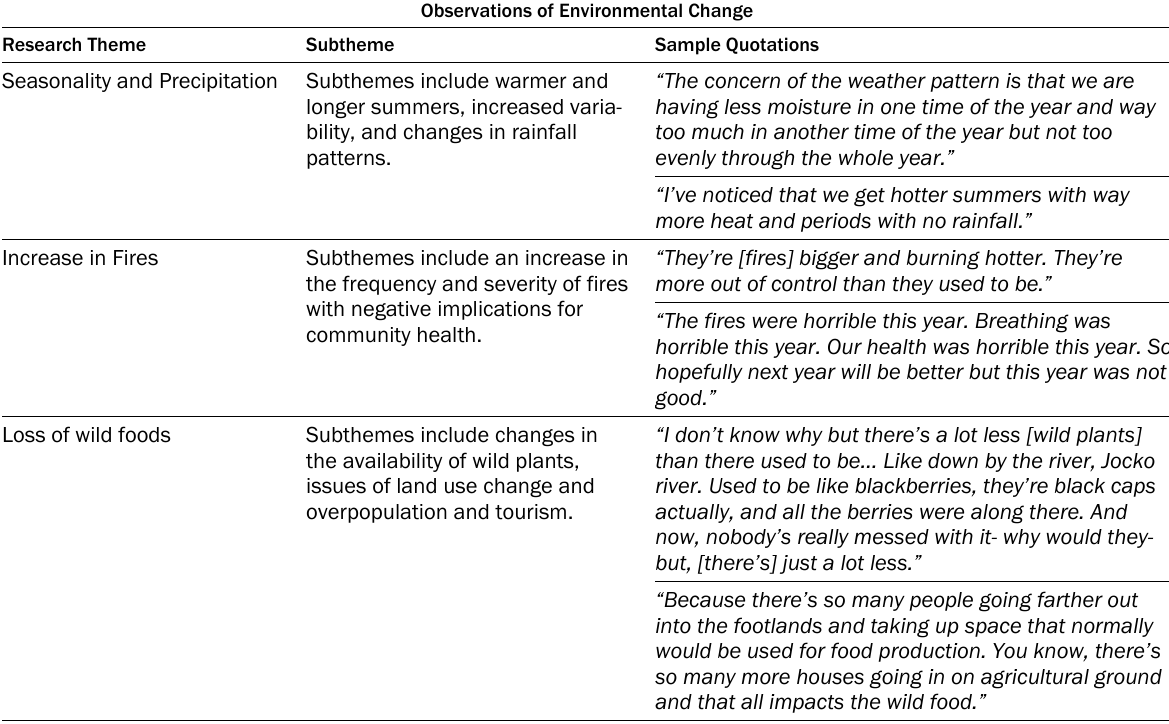
Table 3. Research Themes, Subthemes, and Sample Quotations Regarding Observations of Environmental Change and Wild